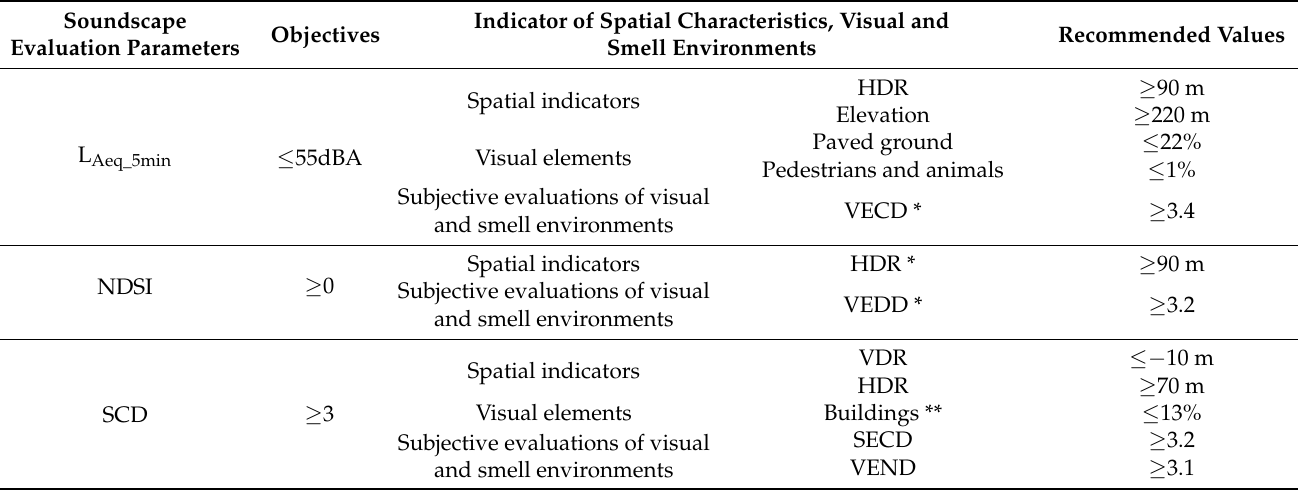
Table 11. The recommended values to achieve positive soundscape evaluation in terms of spatial characteristics and visual and smell